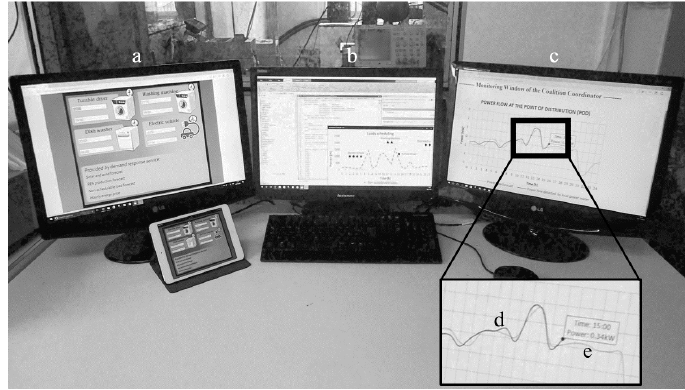
Figure 12. The aggregator; a : graphic-user-interface; b : Matlab; c : power flow monitoring at the point of delivery; d : actual power flow; e : forecast power flow.